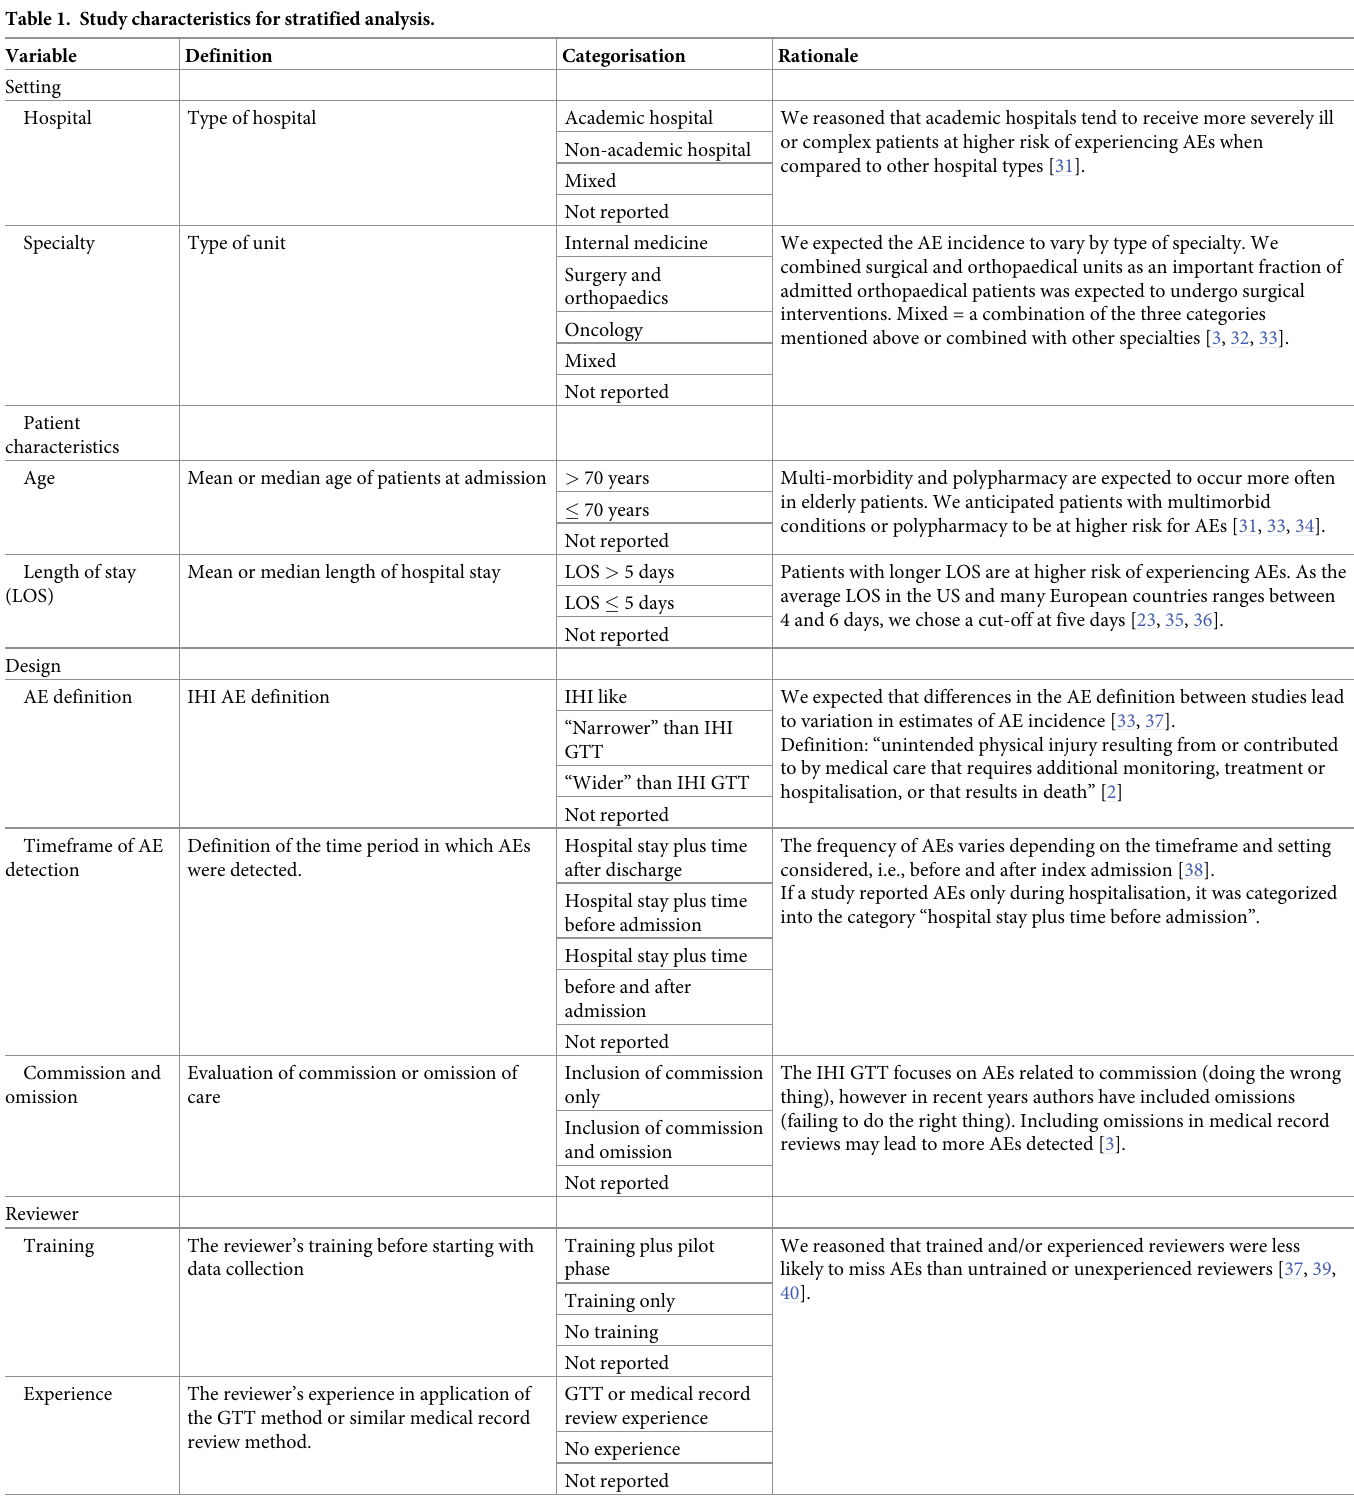
Table 1. Study characteristics for stratified